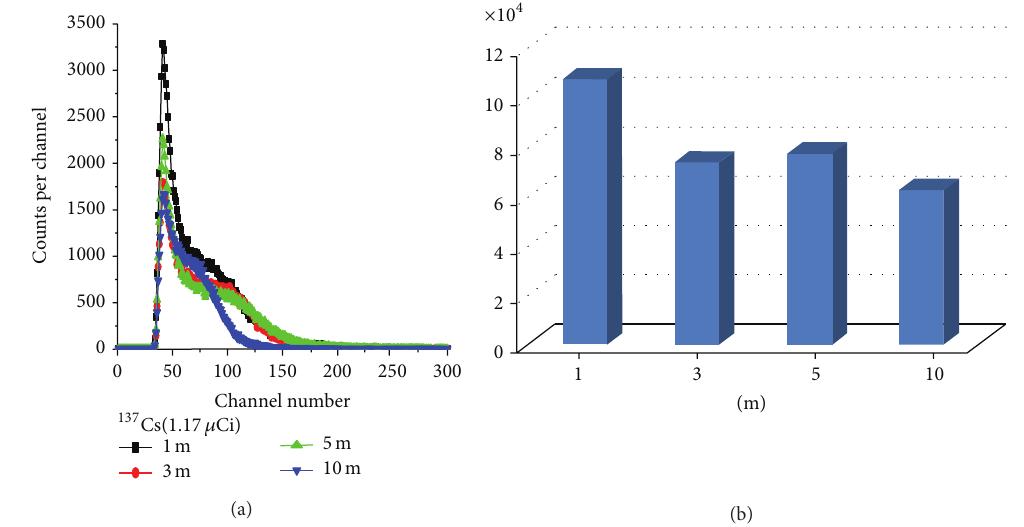
Figure 3: Pulse height spectra on the length of the transmitting optic fiber.